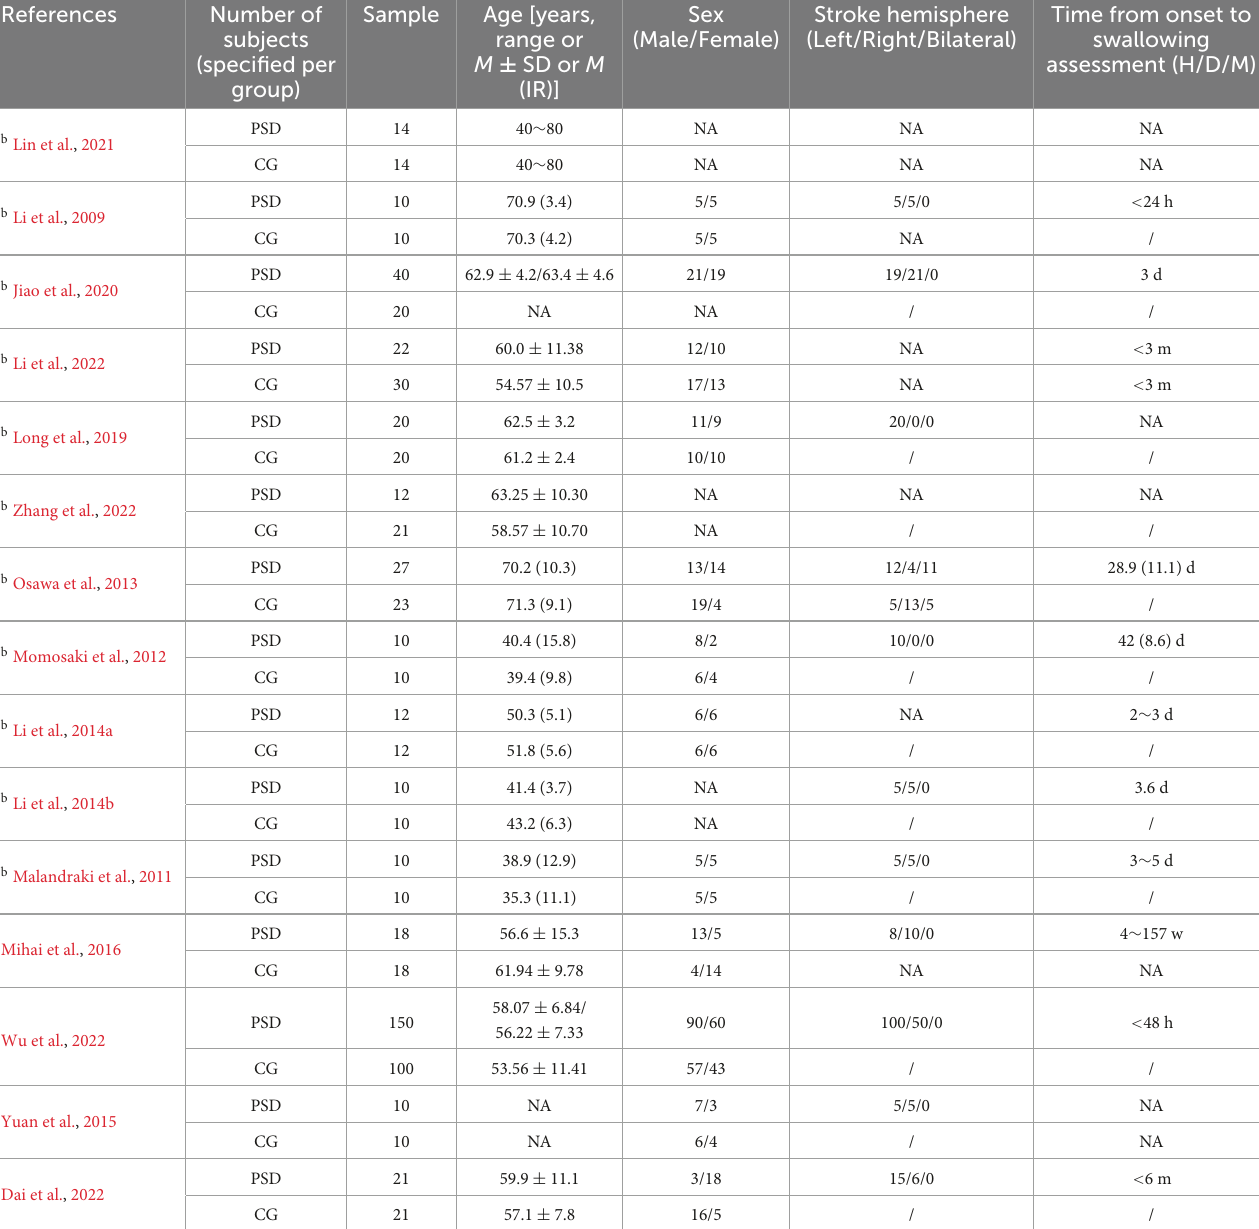
TABLE 4 Summary of demographic data for studies included in functional MRI